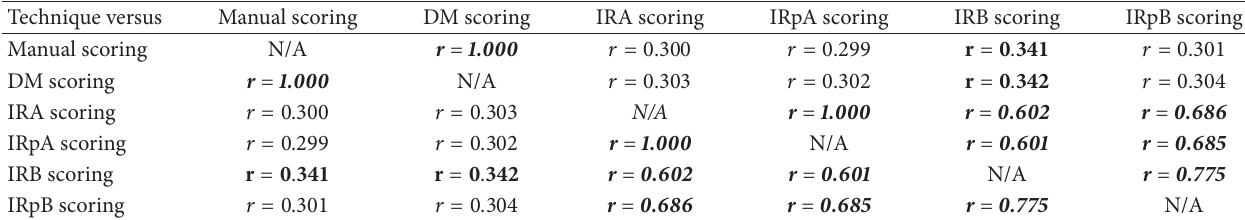
Table 4: The cell counting methods used to determine the labeling index. Pearson’s correlation coefficient was obtained by comparing each method. The manual (manual scoring and DM scoring) and advanced ImmunoRatio methods (IRA scoring and IRpA scoring) had nearly perfect positive Pearson’s correlation coefficients, whereas the basic ImmunoRatio methods (IRB scoring and IRpB scoring) had moderate positive correlation coefficients when compared with the advanced ImmunoRatio method. Italic text indicates moderate to strong Pearson’s correlation and bold text indicates a significance level of 𝑝 < 0.05